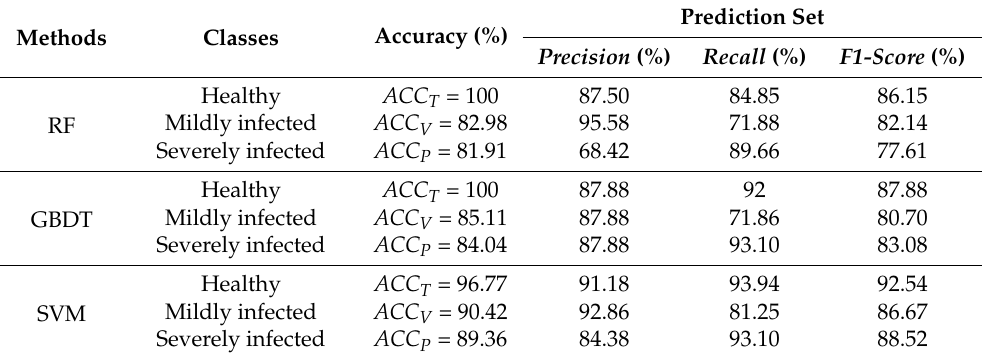
Table 2. Classification of FHB-infected wheat kernels using RF, GBDT, and SVM.